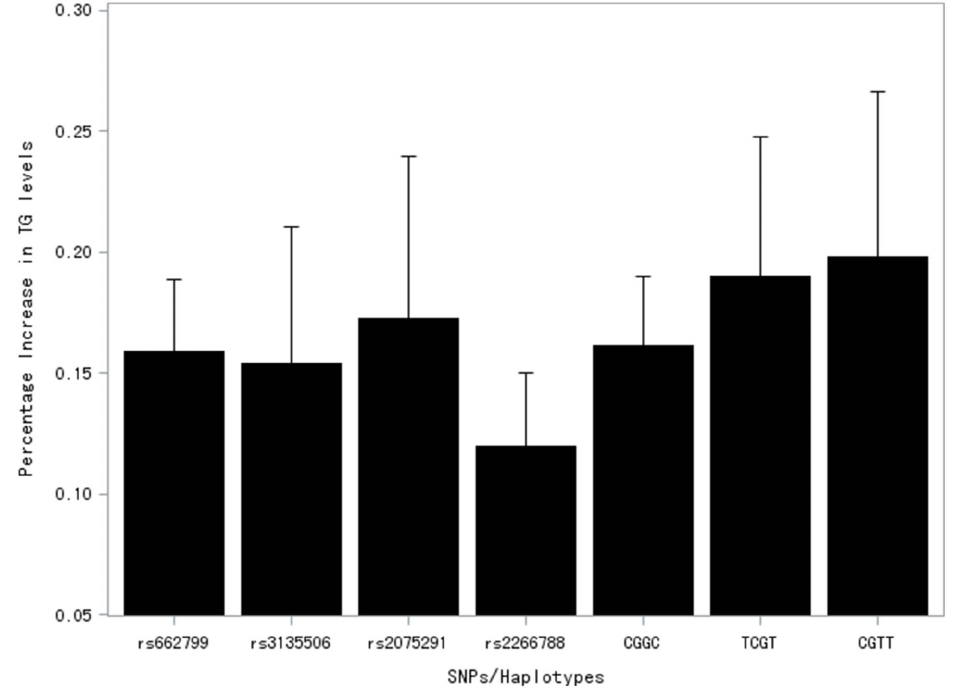
Figure 4. Mean effects and standard errors (bars) in TG levels for each SNP and haplotype. doi:10.1371/journal.pone.0110258.g004 PLOS ONE |